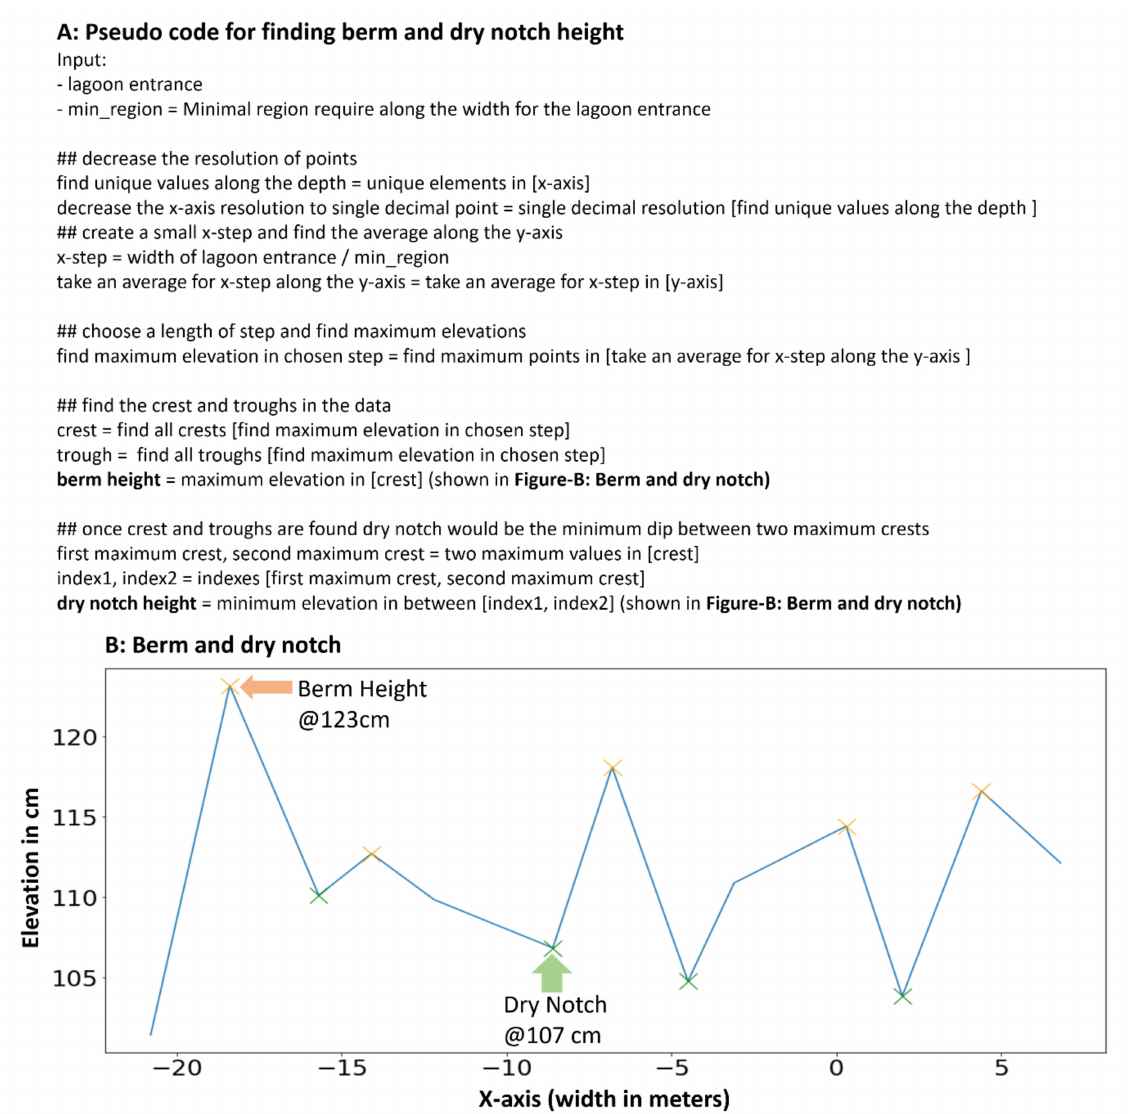
Figure 9. ( A ) Pseudo code for estimating the dry notch height from lagoon entrance; ( B ) Down-sampled elevation data versus width. Berm and dry notch estimation from the elevation data by following steps shown in ( A